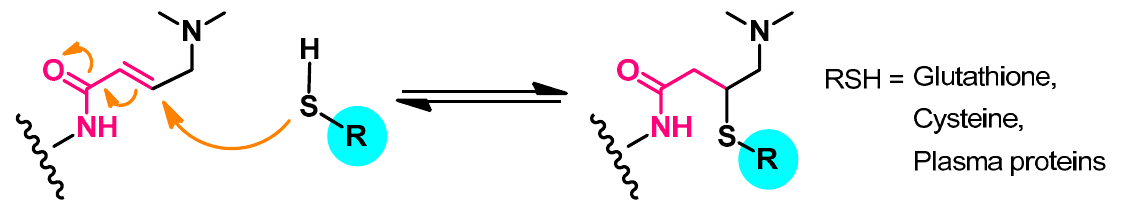
Figure 12. The main metabolic pathway of afatinib.